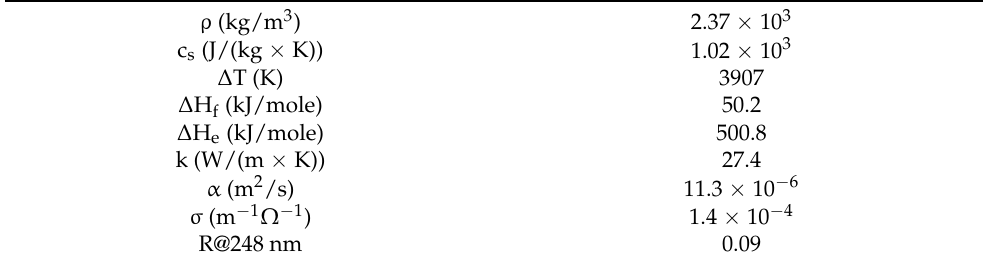
Table 2. The mass, optical and thermal properties of the boron target. All the values are given for standard ambient temperature and